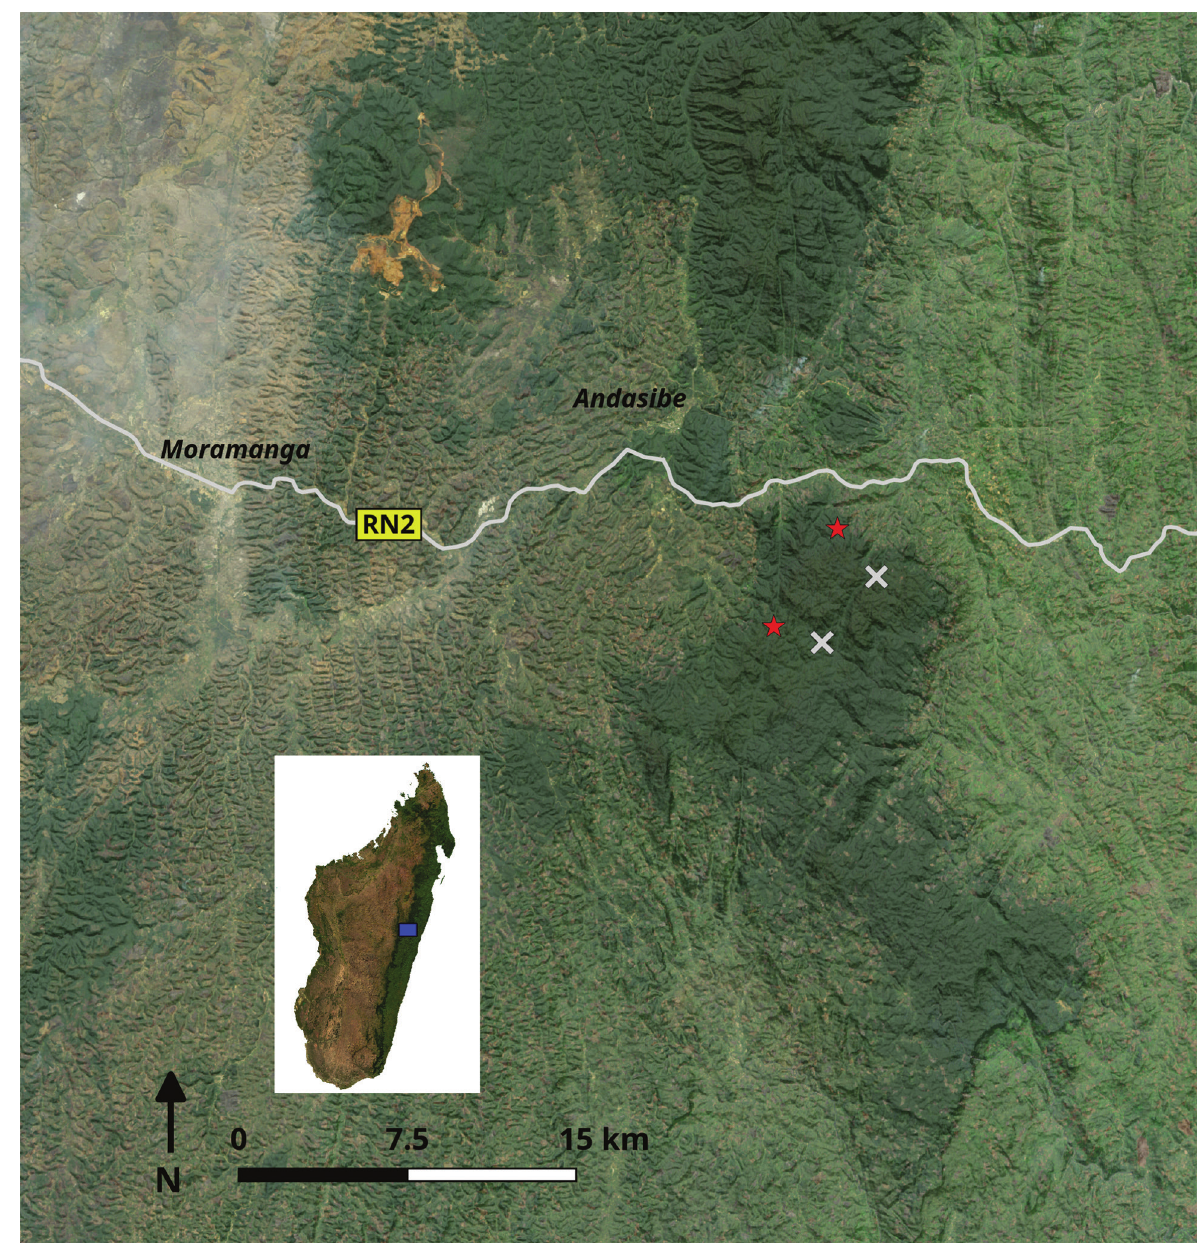
Figure 4. Map showing the location of the known range of Calumma roaloko sp. n. in central-eastern Madagascar. Red stars indicate localities where C. roaloko sp. n. was found, gray “X” indicate localities surveyed but with no detection of the species. The map is a composite of Landsat 7 and SRTM (Shuttle Radar Topographic Mission; Farr and Kobrick 2000) digital elevation data (U.S. Geological Survey (USGS) Earth Resources Observation and Science (EROS) Center) created in QGIS